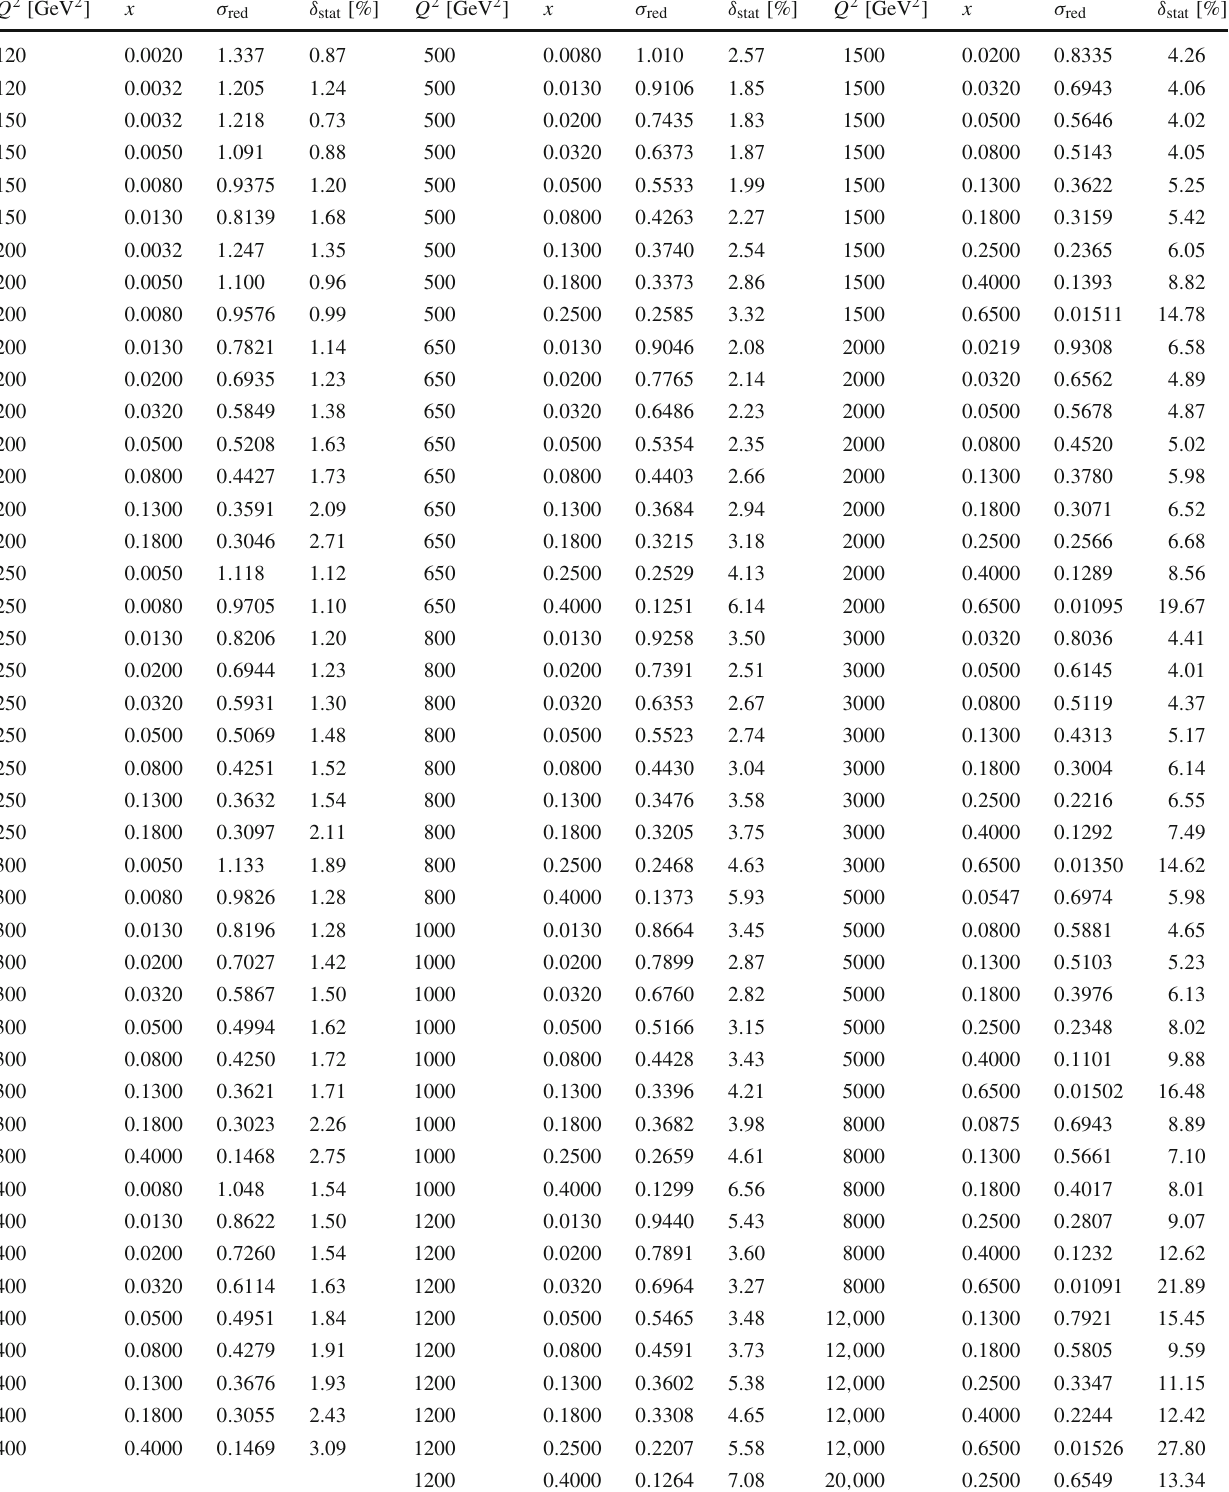
Table 6 The NC e − p reduced cross section σ red with lepton beam polarisation P e = − 25 . 8% with their statistical ( δ stat ) uncertainties. The full uncertainties are available in Ref. [58], while the respective cross section values are updated according to Sect. 3 and Ref.